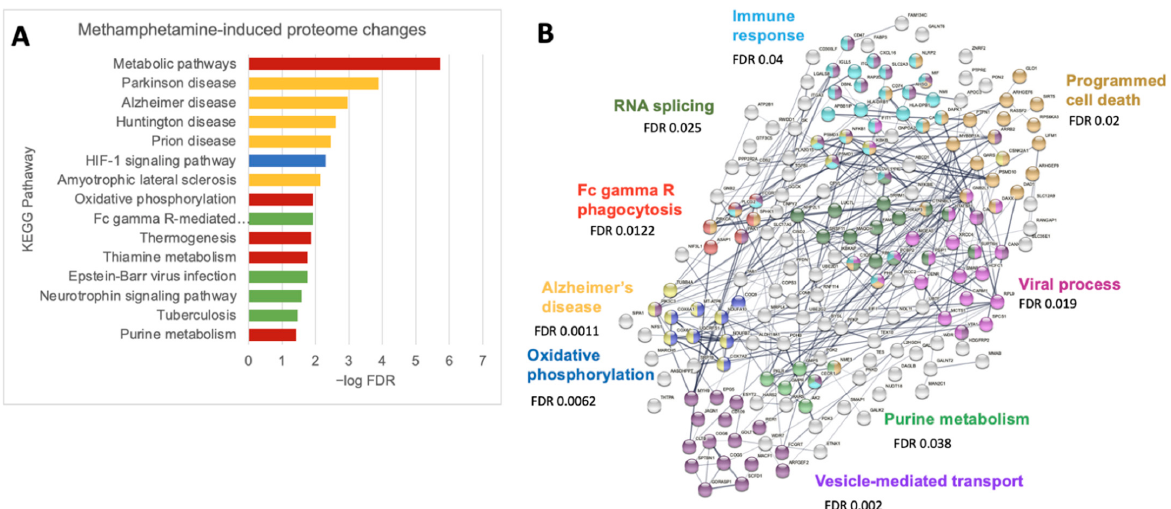
Figure 4. Pathway analyses and interactomes by proteomics in meth-treated HIV-infected macrophages. ( A ) Significantly enriched proteins with fold change of either <0.8 or >0.2 and p < 0.1 were analyzed for pathway analysis using KEGG software. ( B ) Significantly enriched proteins with fold change of either <0.8 or >0.2 and p < 0.1 were analyzed for protein–protein interactions using the STRING database and highlighted according to matching processes.